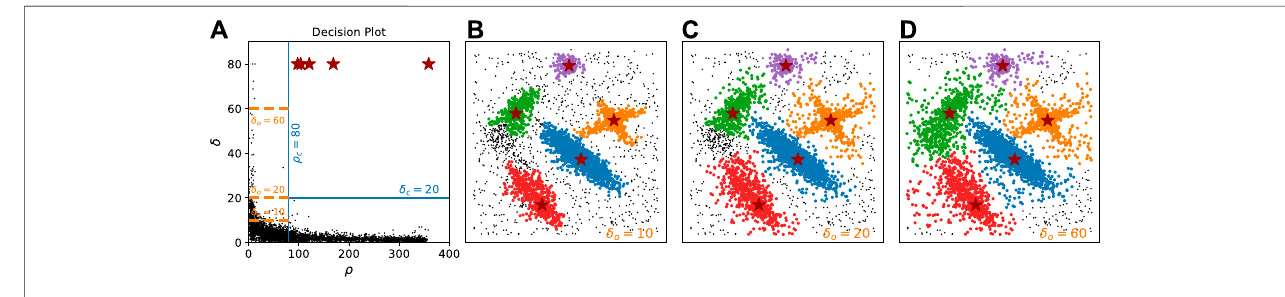
FIGURE 4 | Noise rejection using different values of δ o. Noise is either an outlier or a descendant follower of an outlier. In this dataset (Rodriguez & Laio, 2014), 4,000Pointsaredistributedin500 × 5002Dsquarearea. (A) representsthedecisionplotonthe ρ − δ plane,where fi xed ρ c 80and δ c 40valuesareshownasverticaland horizontal blue lines, respectively. Three different values of δ o (10, 20, 60) are shown as orange dash lines. (B − D) show the results with δ o 10, 20, 60, respectively, illustratinghowincreasing δ oloosensthecontinuityrequirementandhelpstodemoteoutliers.Thelevelofdenoiseshouldbechosenaccordingtotheuser ’ sneeds.